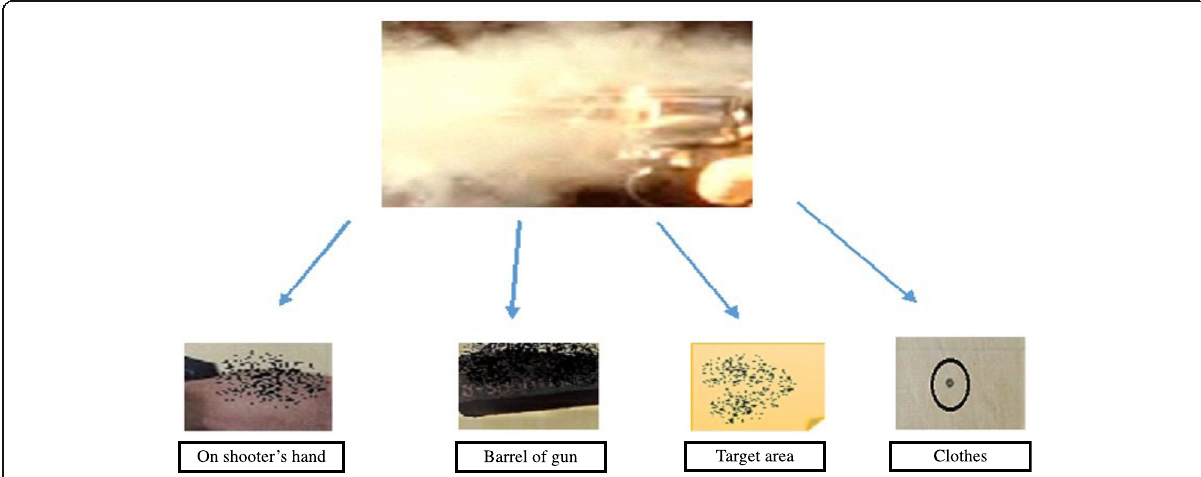
Fig. 2 Schematic diagram showing region where residues encountered at the scene of crime